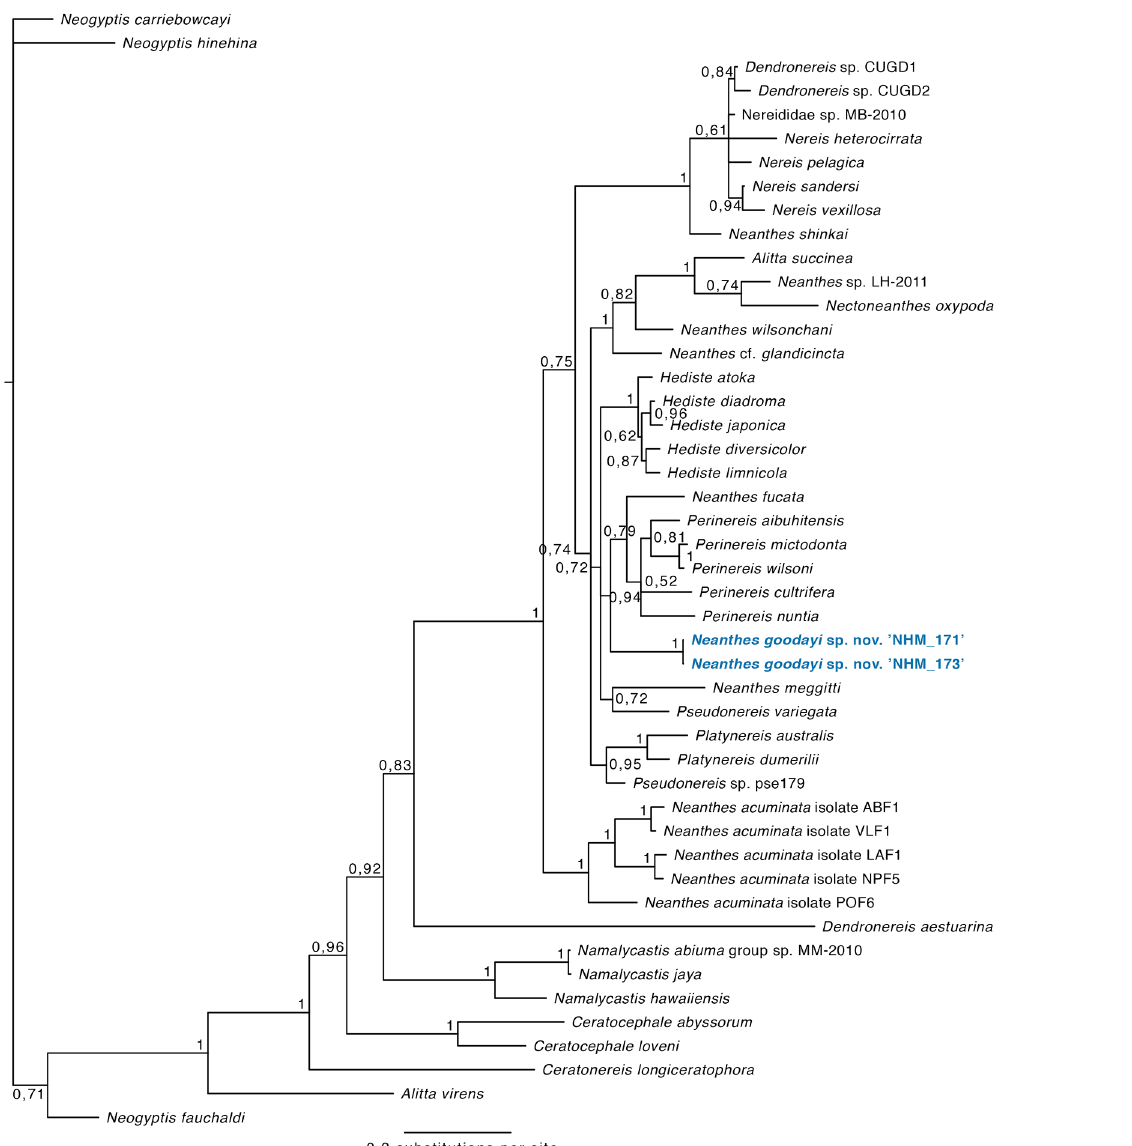
Fig. 7. Phylogenetic analysis of Nereididae Blainville, 1818, 50% majority rule tree from the Bayesian analyses using 18S, 16S and COI, with posterior probability values on nodes. Forty-five taxa from GenBank were included, using three taxa from another family within Nereidiformia, Hesionidae Grube, 1850, as